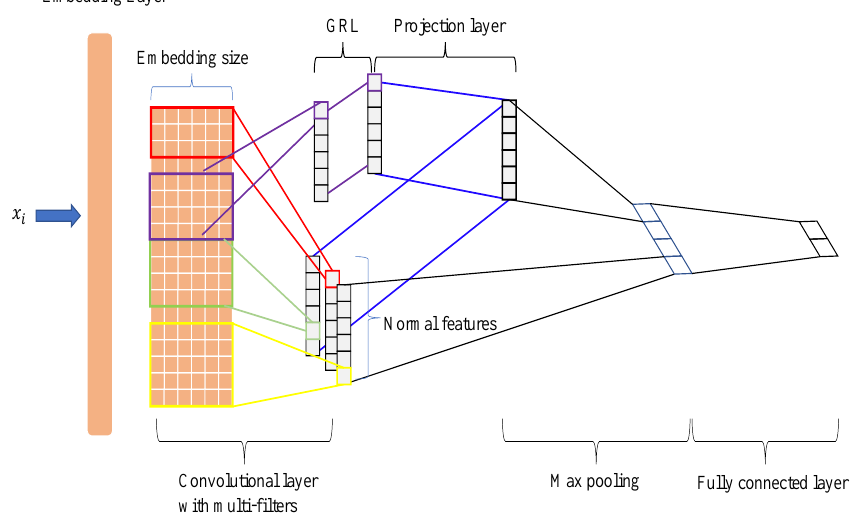
Figure 2. The total structure of the FA-TextCNN . The purple line is the extractor of the auxiliary network that utilizes a gradient reversal layer. As shown in the figure, we concatenated the features after maxpooling and fed the features together to form a fully connected layer.